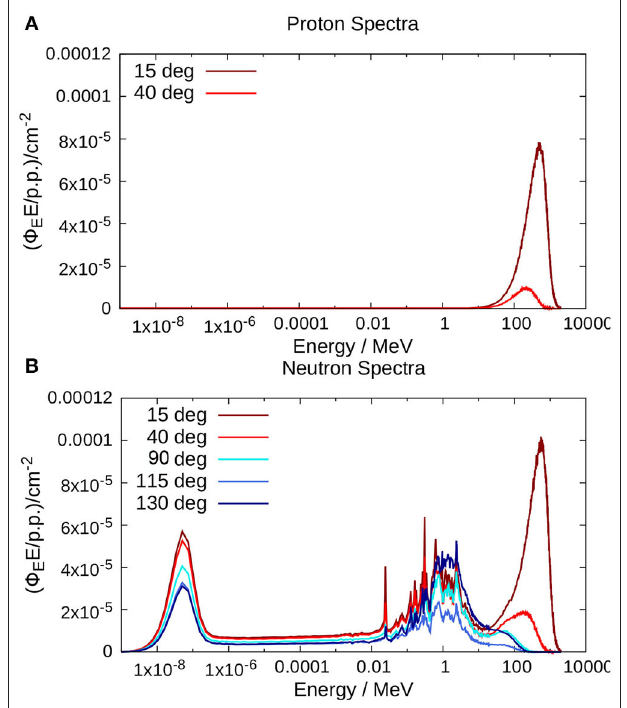
FIGURE 5 | (A) Calculated secondary proton spectrum at the 15 and 40 degree position. (B) Calculated neutron spectrum (fluence per unit lethargy) at the different dosimeter